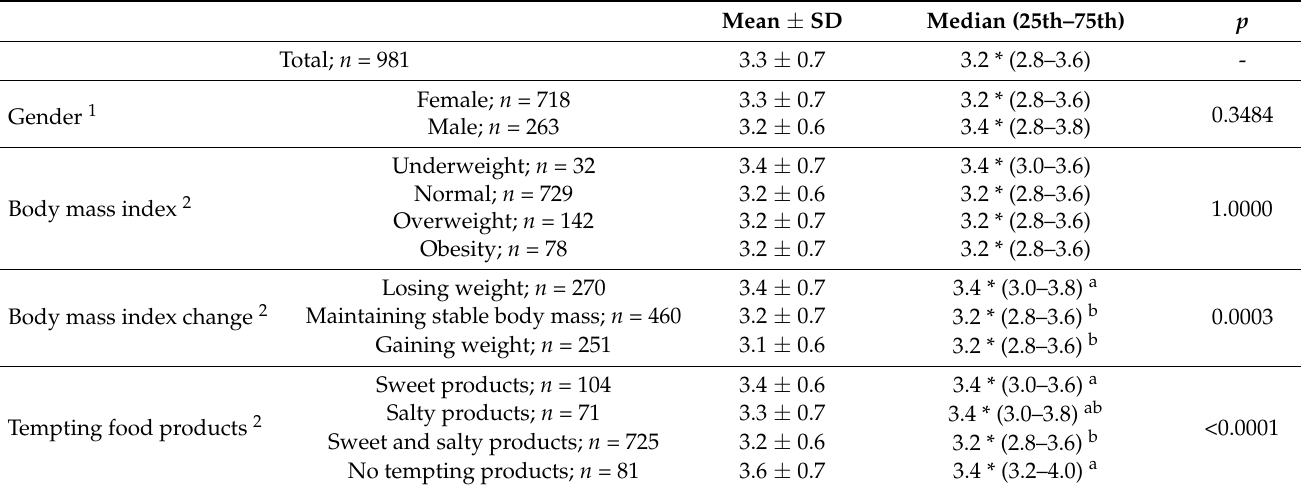
Table 2. The self-regulation of eating behaviors score assessed using the Self-Regulation of Eating Behaviour Questionnaire (SREBQ), within the Polish Adolescents’ COVID-19 Experience (PLACE-19) Study ( n = 981) and in